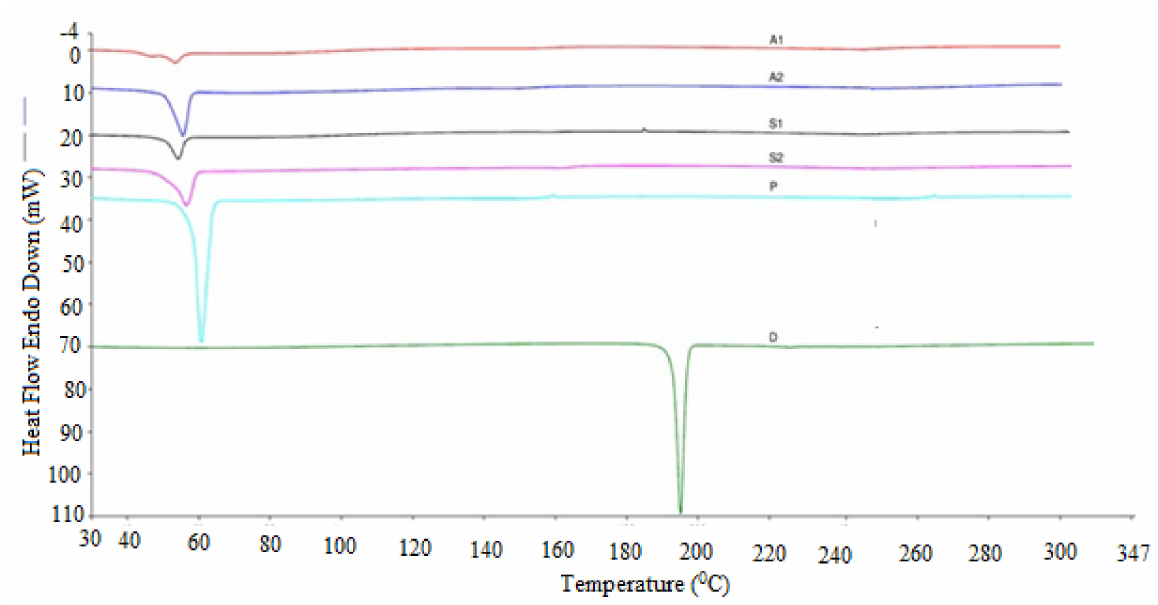
Figure 2. DSC thermograms for pure drug (D) and various SDs prepared using microwave